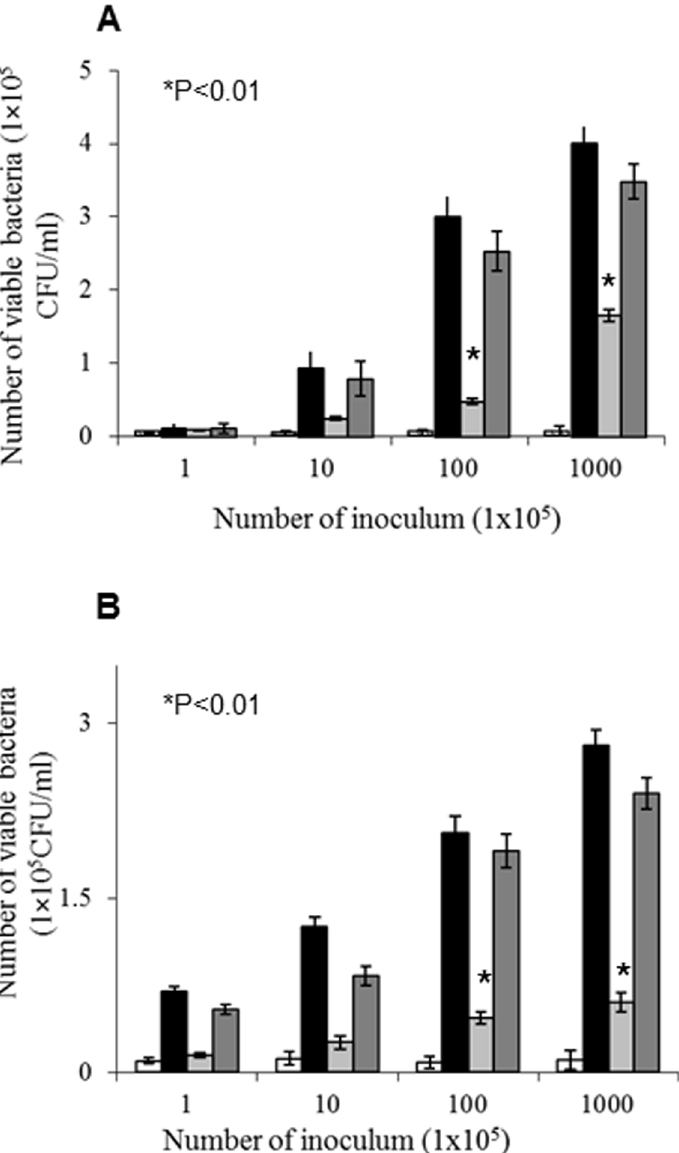
Figure 5. Role of ChiA2 in V.choleraeinvitro and invivo proliferation. A . Comparative study of the survival of wild type and D chiA2 mutant in human intestinal HT29 cell line. The graph represents a dose dependent survival of wild type V. cholerae and D chiA2 mutant and also a complemented strain. B . Comparative study of dose dependent mice intestinal survival of wild type V. cholerae , D chiA2 mutantand the complemented strain. For the experiment, 5 days old suckling mice were fed with different dilutions of the mentioned strains and sacrificed after 16 hours. The viability of the strains was measured by cell count method. Bars: ( % ) PBS; ( & ) wild type V. cholerae ; ( ) D chiA2 mutant ( ) complemented strain. Each of the experiment was repeated thrice (n=3) and the data expressed as means 6 SEM. V. cholerae shows reduced pathogenesis in absence of chiA2 Pathogenesis was studied based on fluid accumulation in infant mouse model. Fluid accumulation with D chiA2 mutant was 40- fold less compared to the wild type V. cholerae infection at 12 h post infection. Fluid accumulation was 50-fold less for D chiA2 mutant with respect to wild type infection at 18 h post infection. Infection with the complemented strain showed significant reversal of the phenotype at both the time points (Fig 6A).